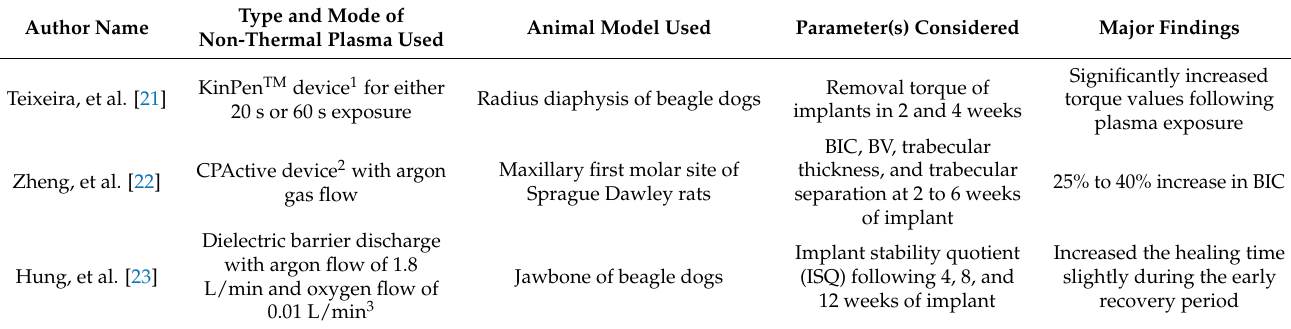
Table 2. Summary of previous studies that considered effects of non-thermal plasma on titanium implant in animal